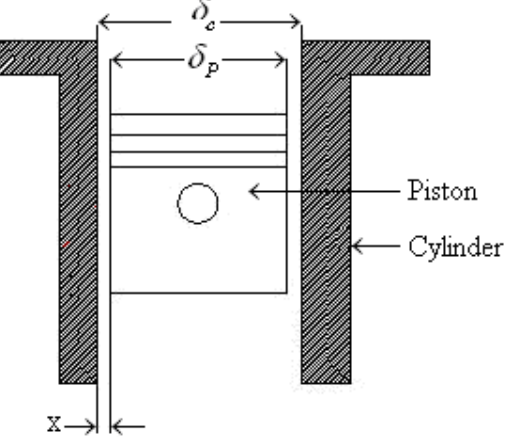
Figure 4 Piston and cylinder